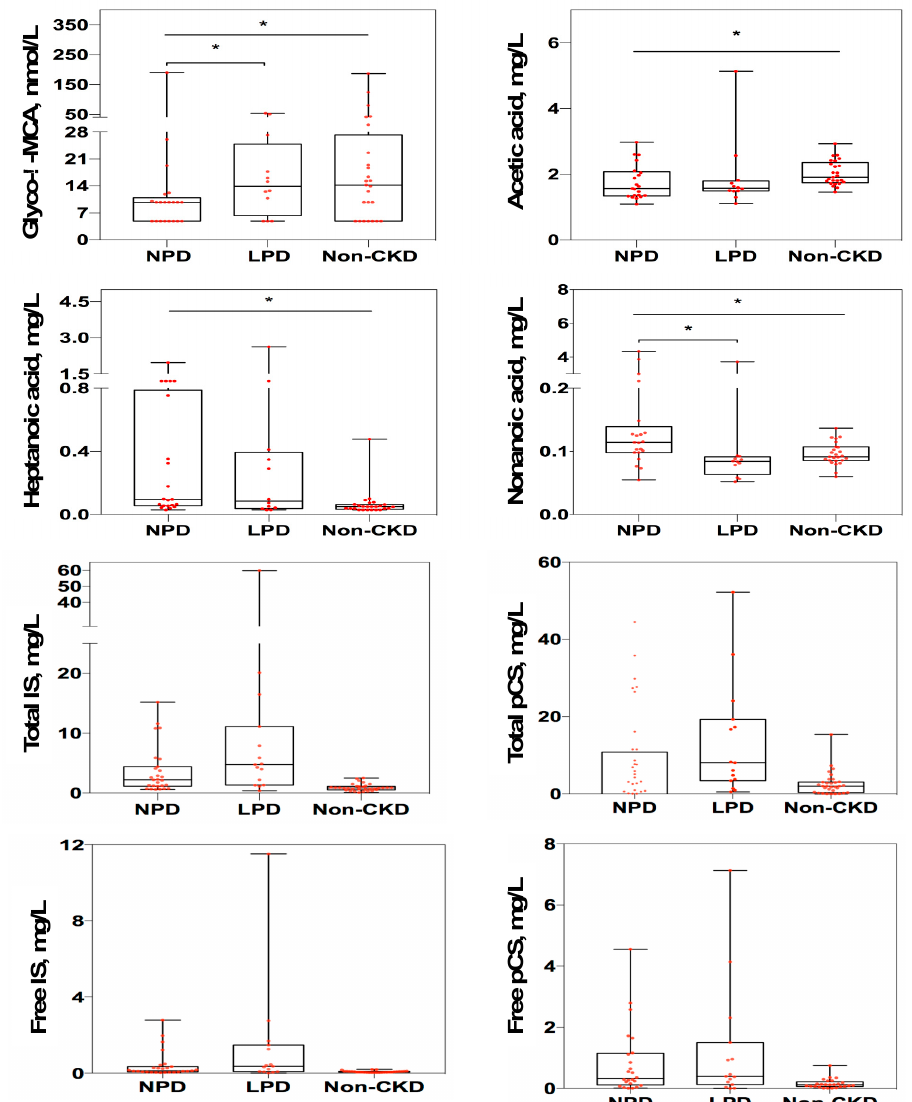
Figure 2. Changes in circulating metabolite concentration associated with LPD in CKD patients. Levels of metabolites among di ff erent groups were analyzed by Wilcoxon rank sum test. The box-plot shows the median, the 25th, and the 75th percentile in each group. *, p < 0.05. LPD, low protein diet; NPD, normal-protein diet; CKD, chronic kidney disease; glyco- λ -MCA, glyco- λ -muricholic acid; IS, indoxyl sulfate; pCS, p cresyl-sulfate.